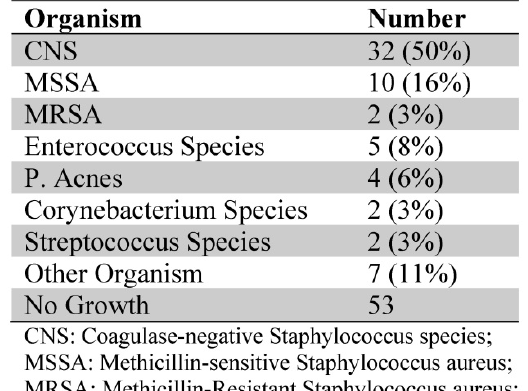
Diagnosis of infection